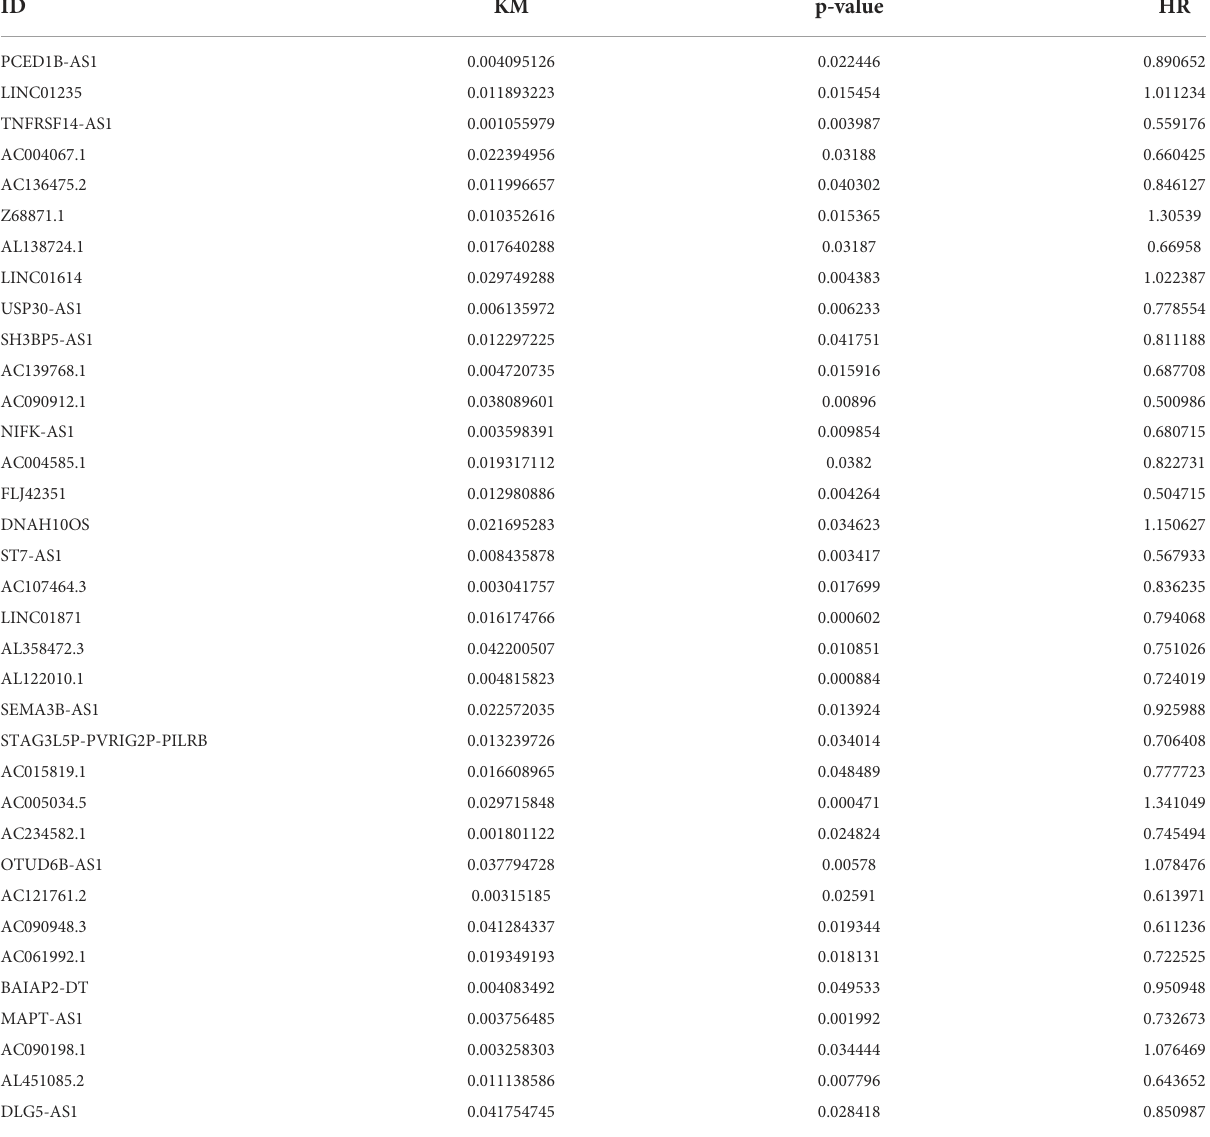
TABLE 1 Thirty- fi ve ARlncRNAs signi fi cantly correlated with OS by univariate Cox analysis combined with Kaplan – Meier survival analysis.